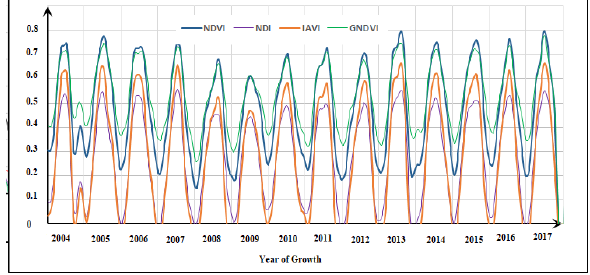
Table 1. Spectral Equation of Vegetation Indices